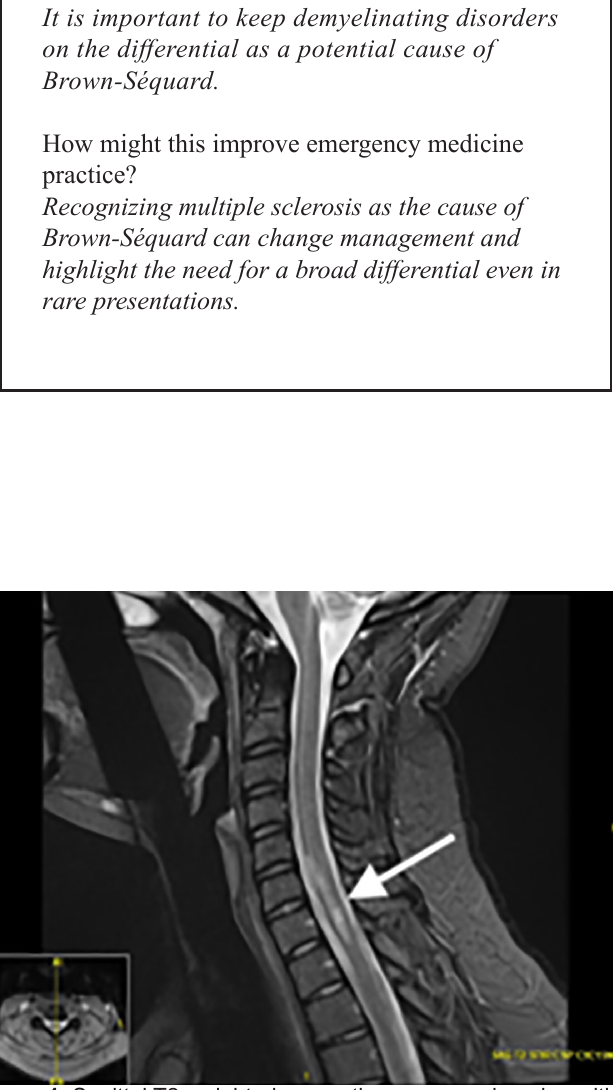
Image 1. Sagittal T2-weighted magnetic resonance imaging with asymptomatic hyperintensity within the cervical spine, worse at cervical level 5-7